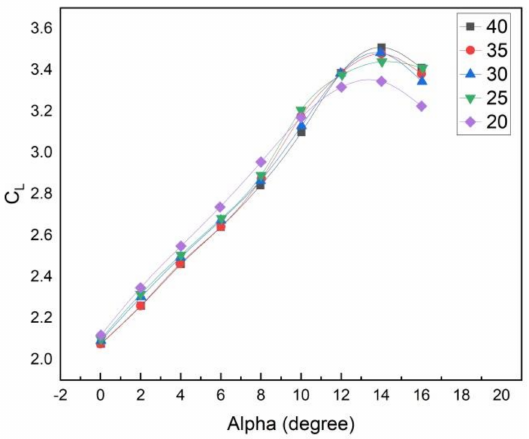
Figure 3. Curves of the lift coefficient versus deflection angle.